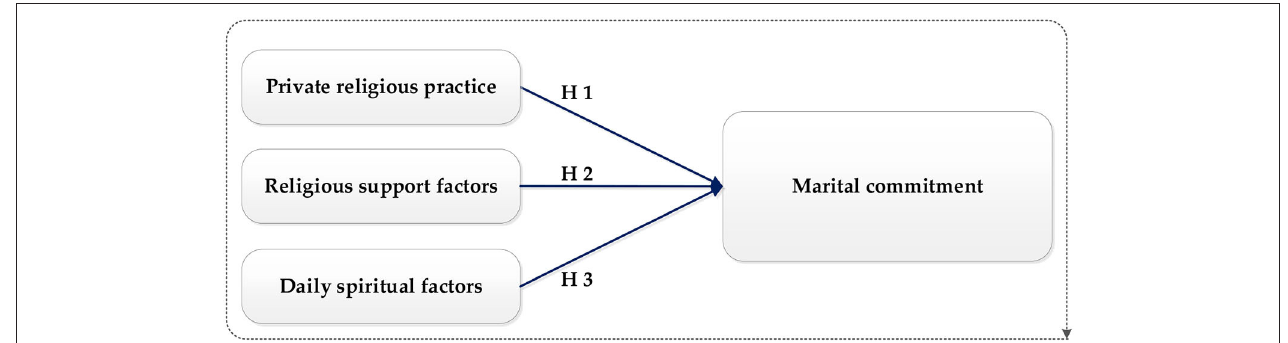
FIGURE 1 | Conceptual framework of marital